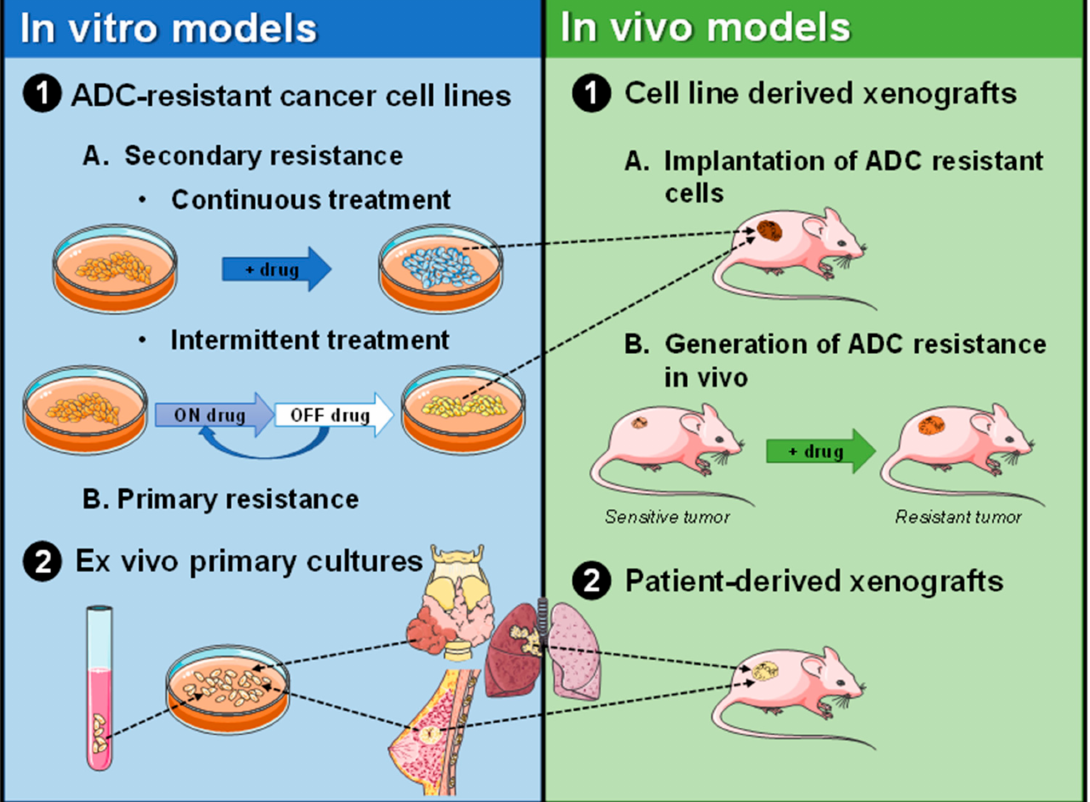
Figure 3. Schematic representation of the generation of preclinical models of ADC